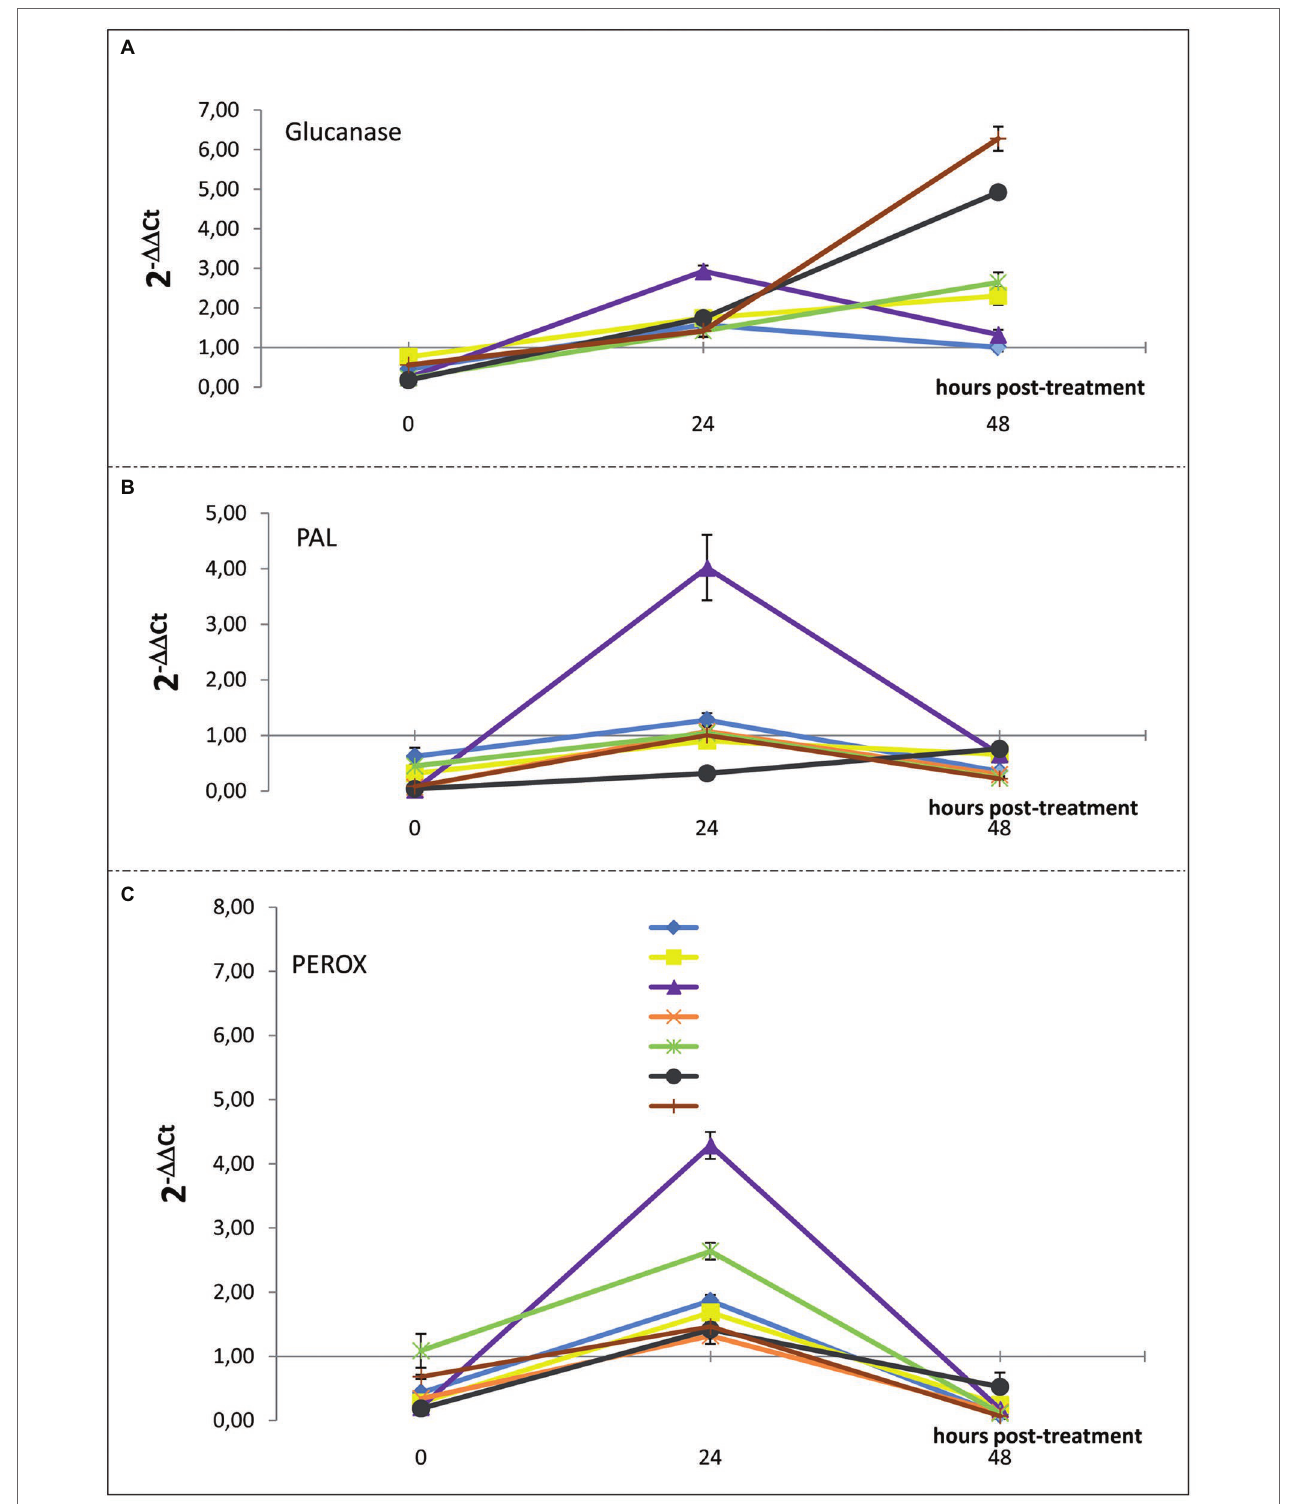
FIGURE 6 | Time course of the expression levels of (A) β -1,3-glucanases, (B) PAL, and (C) PEROX-encoding genes in sweet orange ( Citrus sinensis ) fruits cv. Moro nucellare wounded and treated with water or IMZ-50 (emulsifiable concentrate formula at 50% w/v of active ingredient - a.i.) at 500 ppm a.i., IMZ-S (formula at 7.5% w/v of a.i.) at 187.5 ppm a.i., K-Phi formula (57% w/v) at the dosage of 0.25%, BIOS formula at the dosage of 0.15%, Mixture A (K-Phi: 0.25%; IMZ-50: 500 ppm a.i.), and Mixture B (BIOS: 0.15%; IMZ-S: 187.5 ppm a.i.). Bars represent